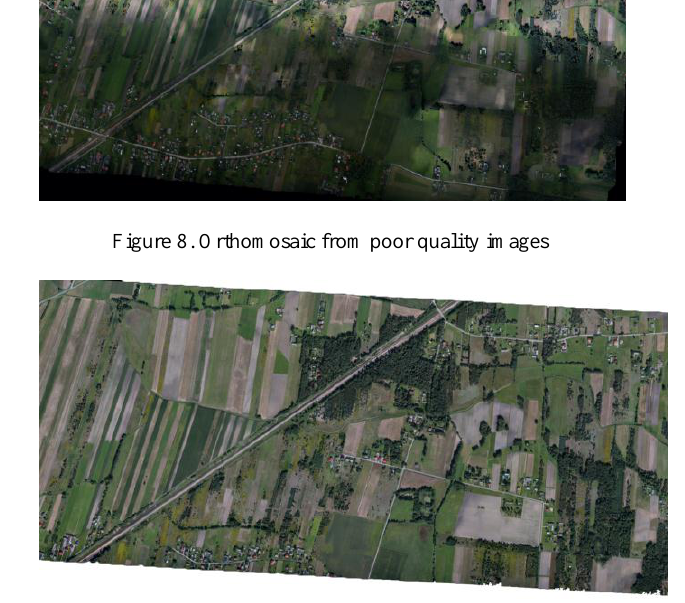
Figure 9. Orthomosaic from good quality images